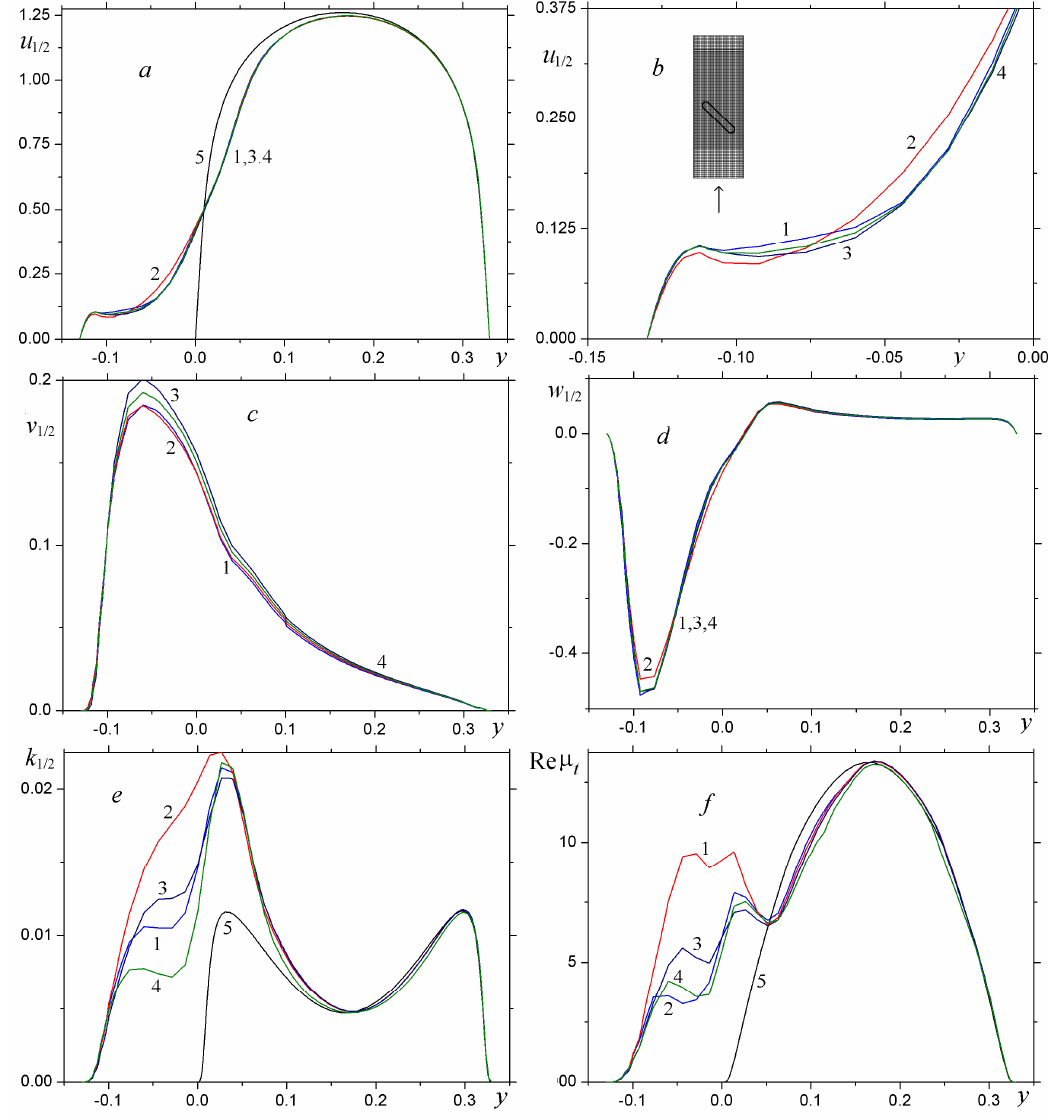
Figure 8. Distributions of longitudinal ( a , b ), vertical ( c ), transverse, ( d ) components of local flow velocity, turbulence energy ( e ) and normalized vortex viscosity ( f ) in the center of the oval dimple of width 0.383 obtained by the modified SST model: 1—SST model [34]; 2—SST model [35]; 3—SST model [35] with RLI correction; 4—SST model [35] with SM correction; 5—plane-parallel channel. b —longitudinal velocity component distribution (enlarged